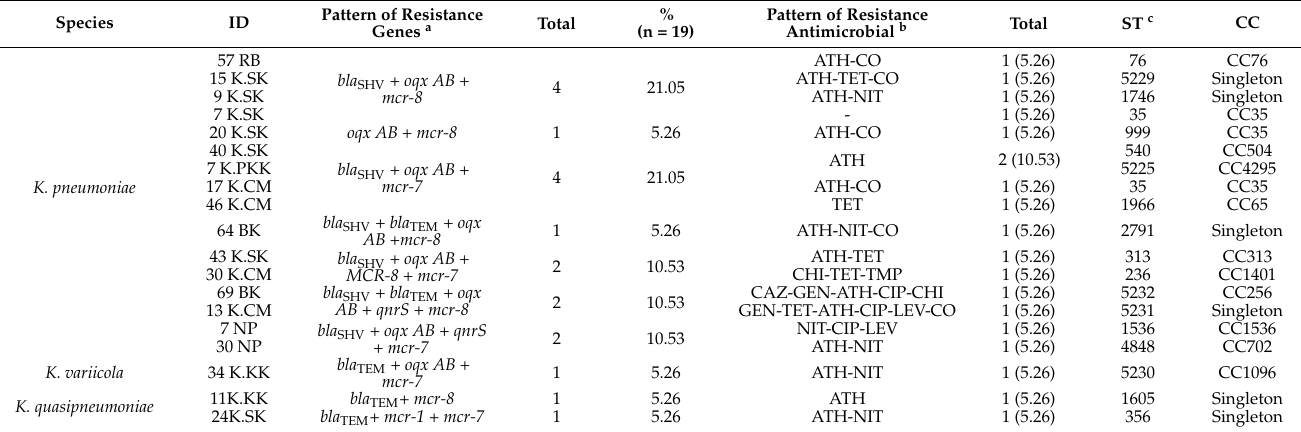
Table 4. Antimicrobial resistance profiles of KpnC isolated from slaughtered pigs in Thailand.